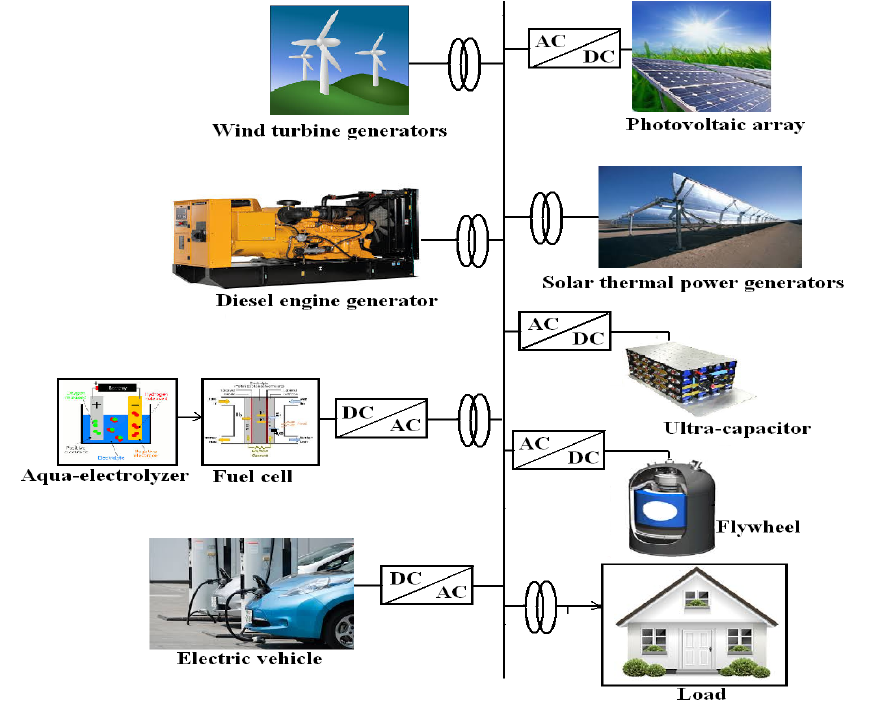
Figure 1. Single line diagram of the hybrid power